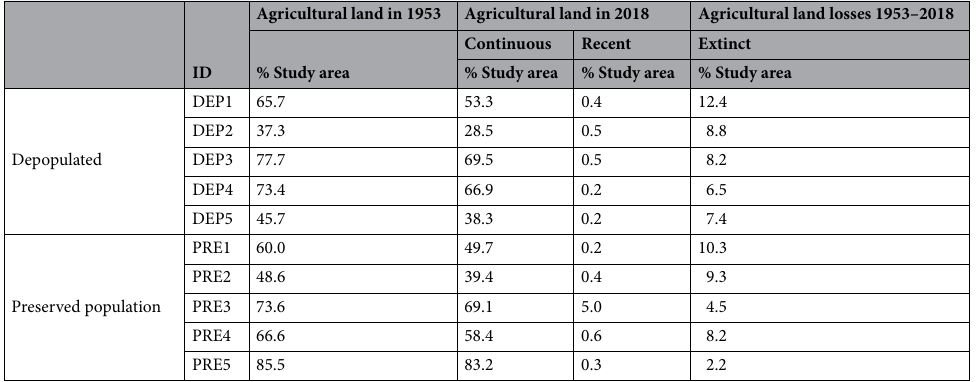
Table 3. Agricultural land persistence for depopulated areas (DEP1–DEP5) and areas with preserved population